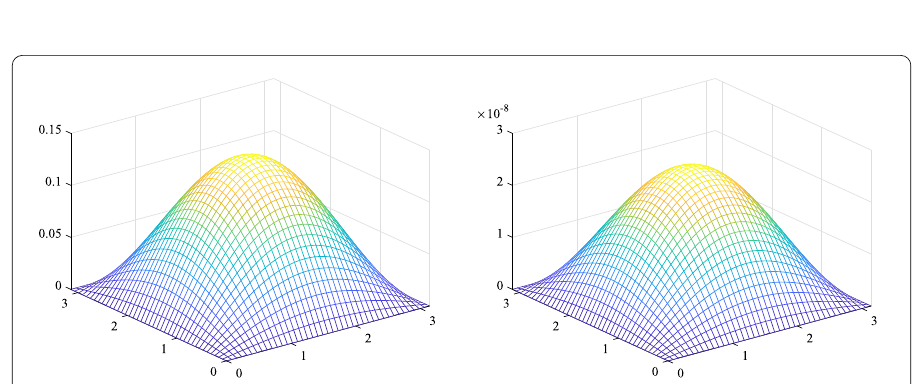
Figure 8 The E-CFDS6-SSM solution (left-hand side) and error of E-CFDS6-SSM (right-hand side) when J = 41 and t = 2 for SP 3